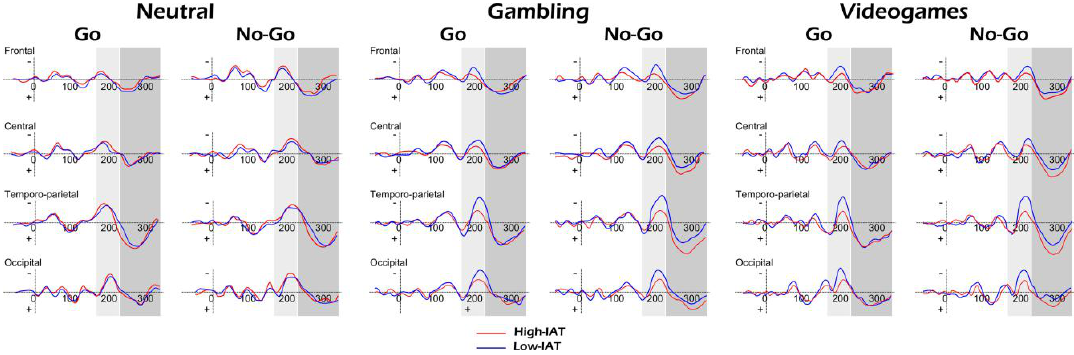
Figure 3. Mean peak ERP amplitude of FRN/P300 for high-BAS and low-BAS